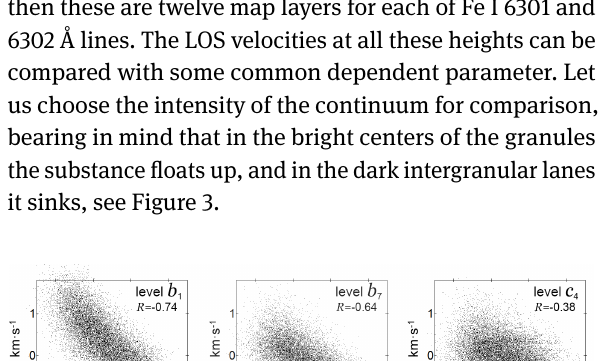
Table 1. The relative positions of the layers on height scale